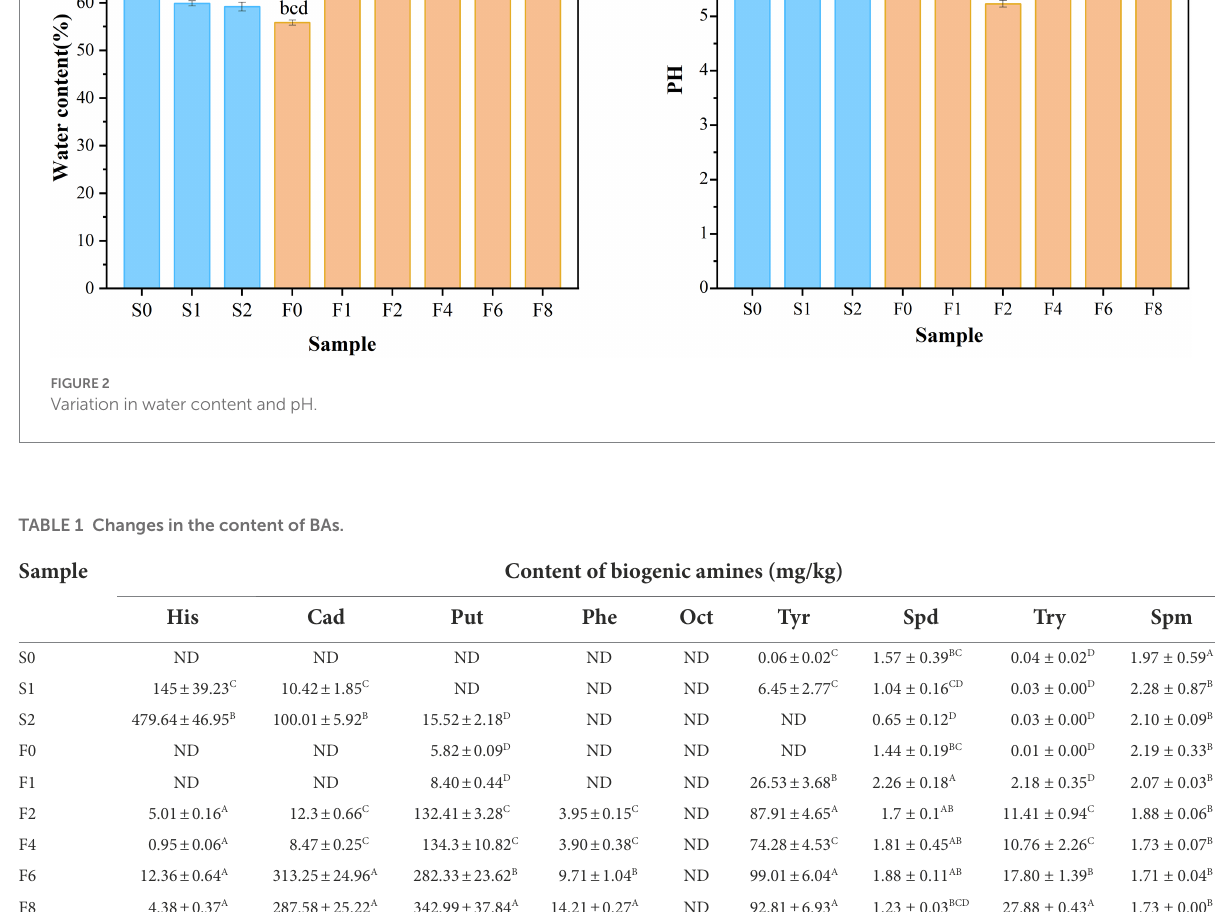
Values with different capital letters are significantly different ( p < 0.05). S0, S1, S2 denote the controls on day 0, 1, 2, respectively; F0, F1, F2, F4, F6, F8 denote zaoyu on day 0, 1, 2, 4, 6, 8, respectively; Z denotes the fermented rice, and the same below. The same